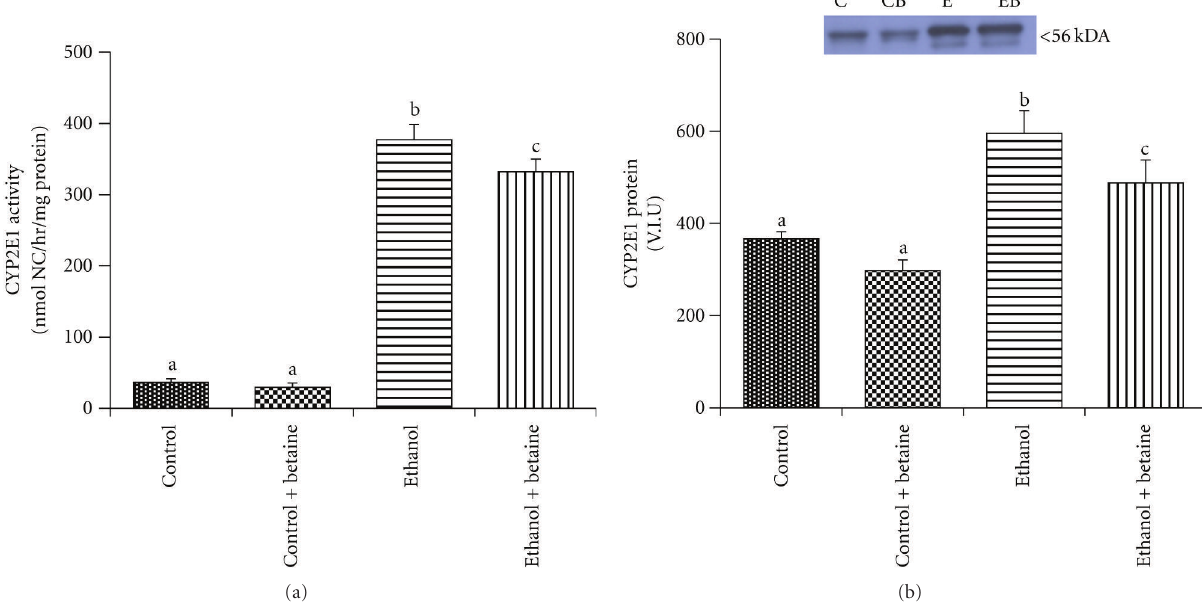
Figure 5: Betaine has minimal e ff ect on chronic ethanol-dependent increase in CYP2E1 activity and protein. (a) Hepatic CYP2E1 activity was determined as detailed in Section 2. Data represent the mean ± S.E.M. for n = 8 animal per groups. Values not sharing a common letter are statistically di ff erent, P < 0 . 05. (b) CYP2E1 protein levels were measured by immunoblotting. The bar graph results represent the mean volume integration units (V.I.U) ± S.E.M. for n = 8 animals per group. Values not sharing a common letter are statistically di ff erent, P < 0 . 05. The top figure shows representative immunoblots of CYP2E1 protein for one pair of untreated and one pair of betaine-treated control and ethanol